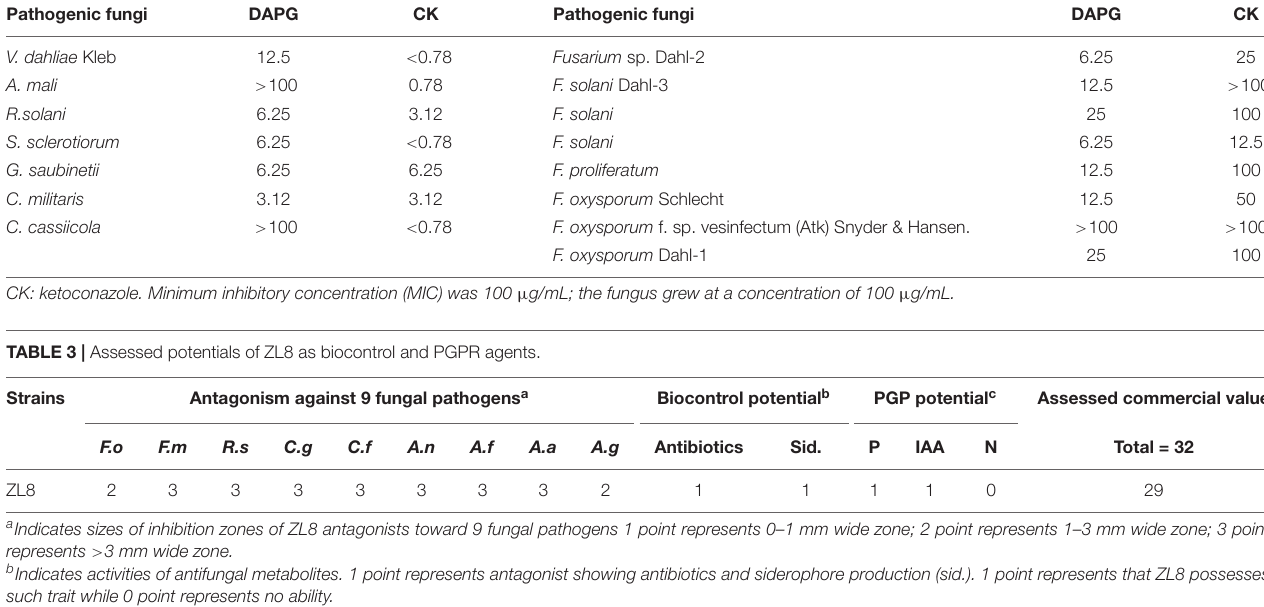
TABLE 2 | Inhibitory effects of diacetylphloroglucinol (DAPG) against fungal pathogens. Pathogenic fungi